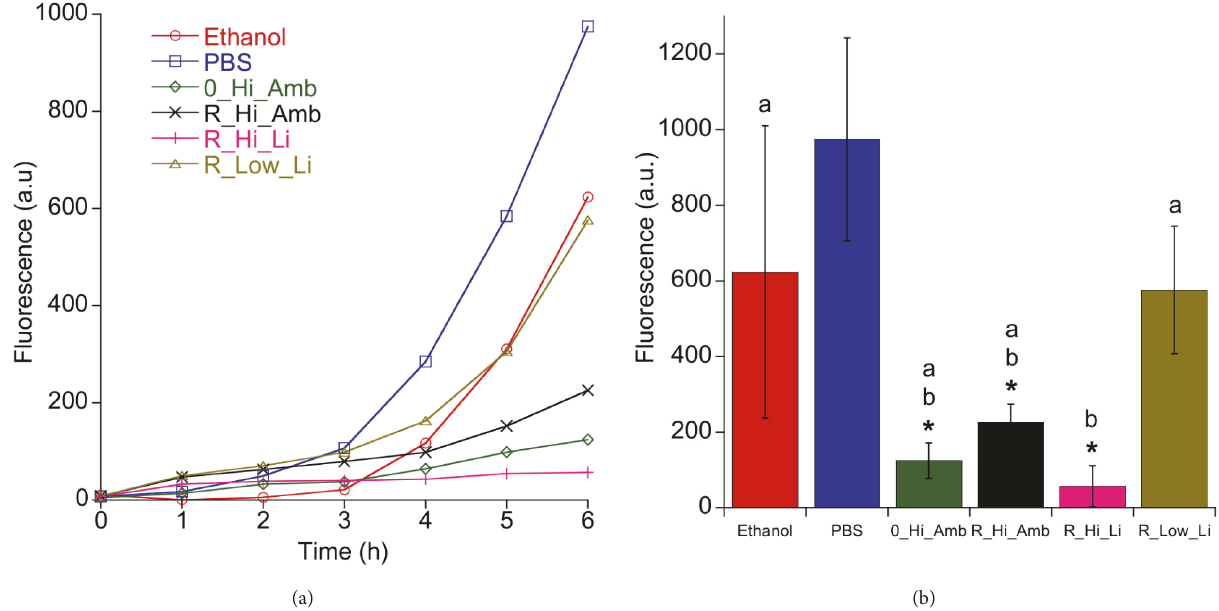
Figure5:Regrowthof P.aeruginosa afterdifferentdebridementtreatments.(a)Fluorescencemeasuredduringreincubationafterdebridement with different treatments (n=8). (b) Average fluorescence intensity after 6 h regrowth. Groups with an asterisk indicate statistically significant difference compared to the control PBS (Dunnett post hoc test, p ≤ 0.05). Groups with different letters are significantly different (five test groups compared, Tukey post hoc test, p ≤ 0.05).